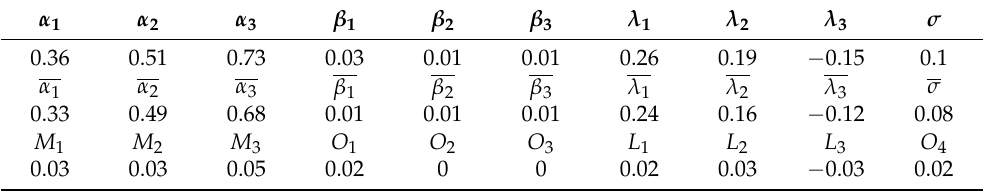
Table 3. Parameter initial settings for multi-agent impact contributions simulation.